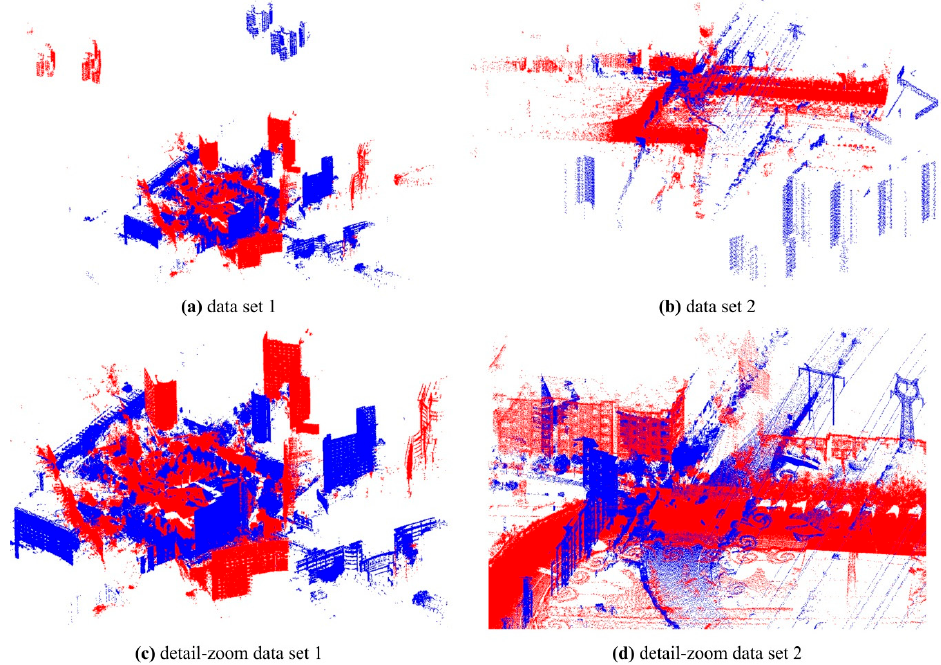
Figure 9 . The examples of the situations where the registration goes wrong. The red data are target point clouds and the blue data are source point clouds. ( a ) The mismathed point clouds of data set 1; ( b ) the mismathed point clouds of data set 2; ( c ) a detail-zoom of ( a ); ( d ) a detail-zoom of ( b ).